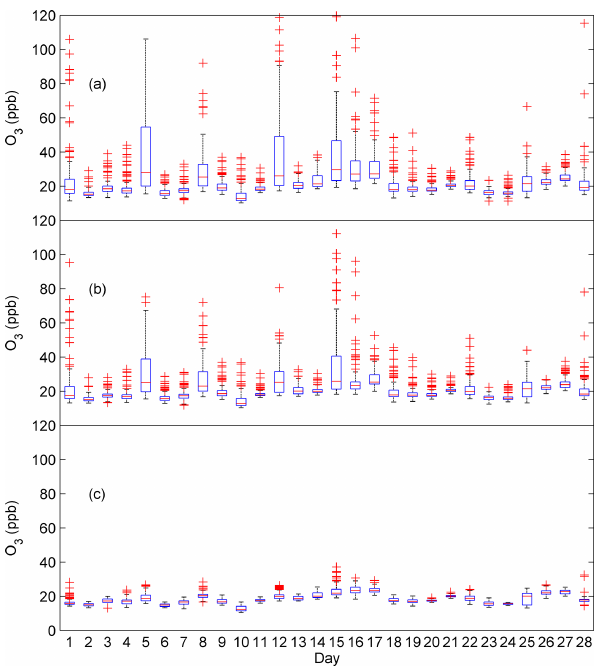
Figure 2. Box-and-whisker plot of near-surface ozone concen- trations for historical emissions (case A), present-day emissions (case B), and planned future emissions (case C). On each day of the simulated month, the time period for the statistical analysis corre- sponds to 12:00 and 16:00 local time. The region of areal averaging is 10km × 10km, centered on 3.1 ◦ S, 60.0 ◦ W (boxed regions of Figs. 1 and 3). The bottom and top of the blue boxes correspond to the first and third quartiles, respectively. The red line inside the box is the median. The whiskers represent the full range of values ex- cluding outliers. The red crosses show outliers, as defined by more than 1.5 times the interquartile range.